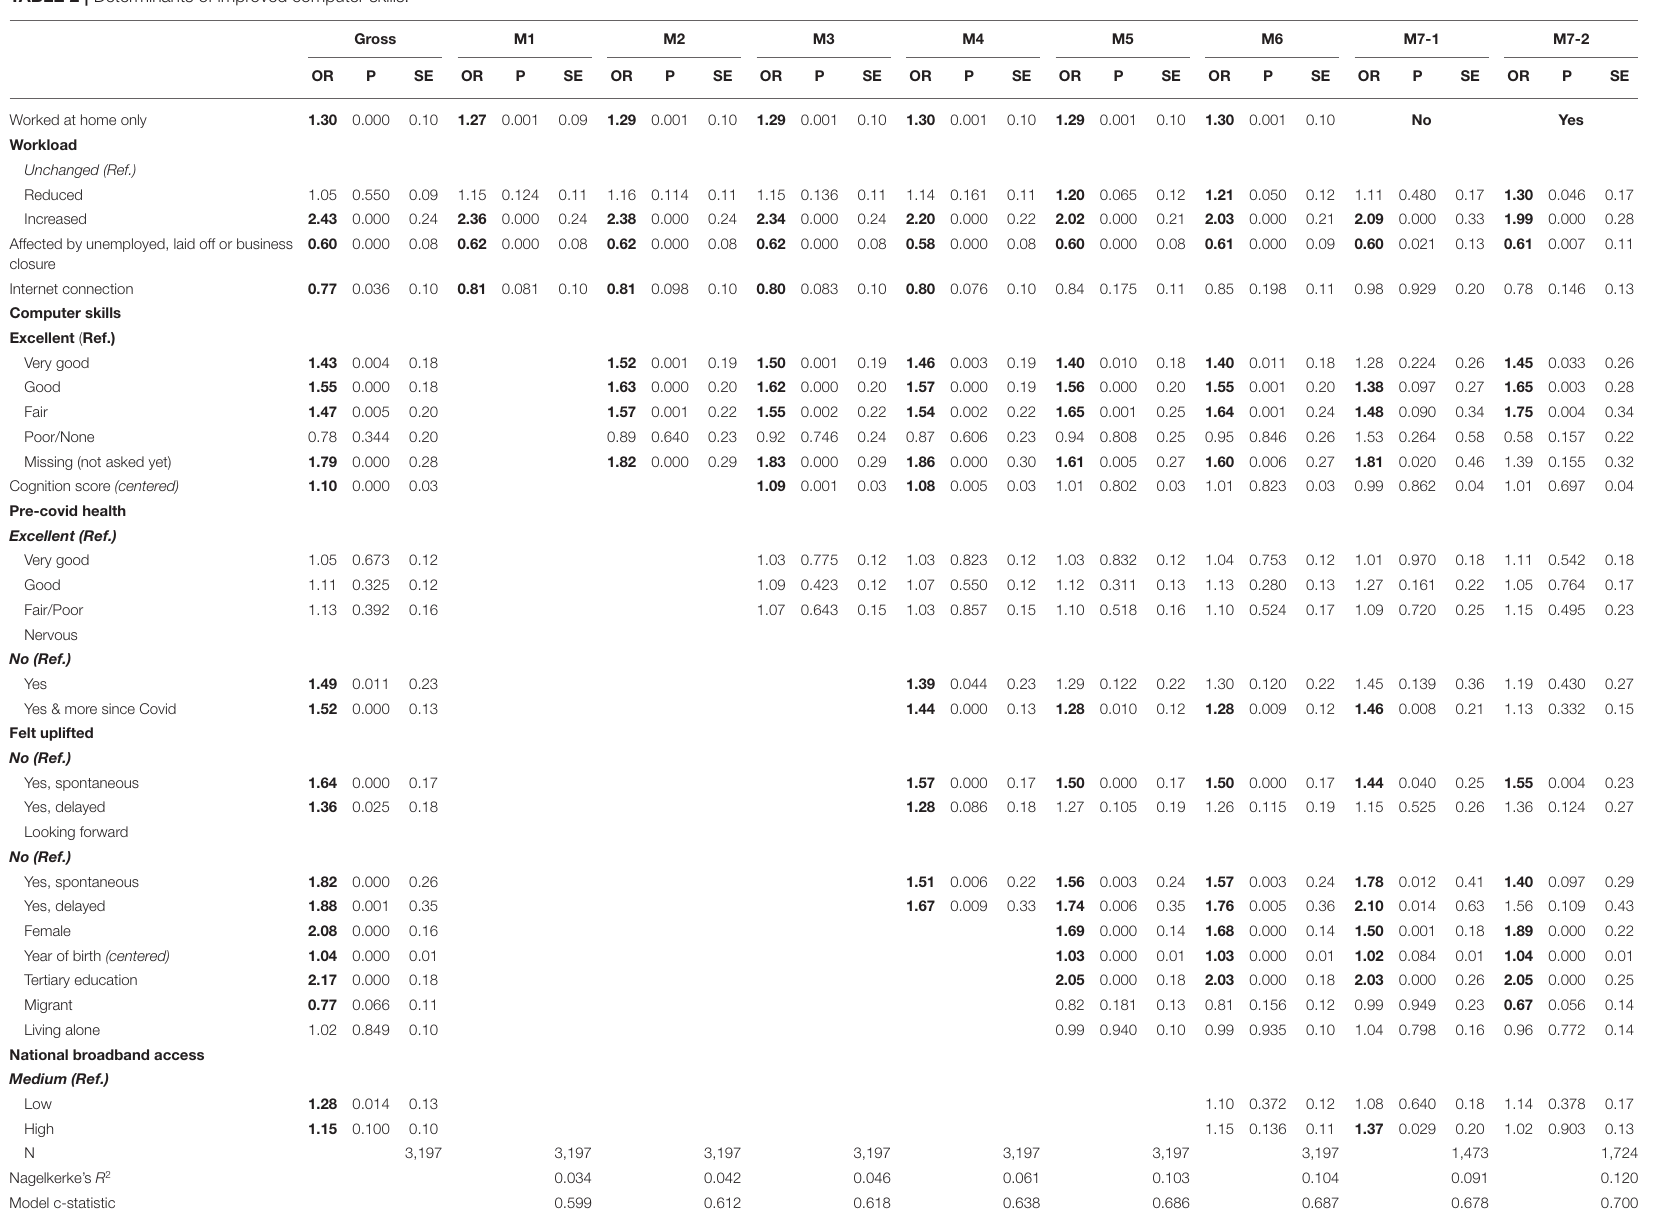
TABLE 2 | Determinants of improved computer skills.